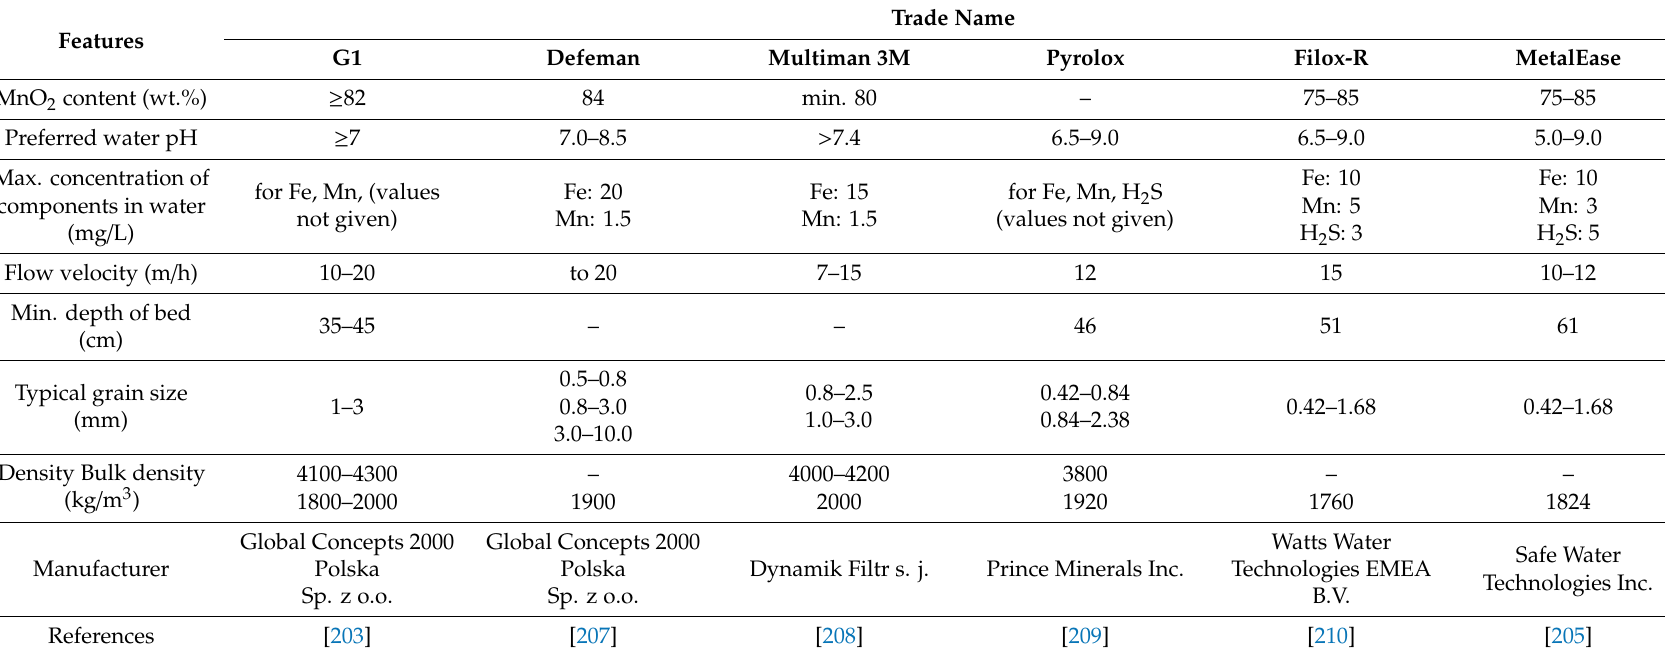
Table 7. Features of commercial catalytic filter media consist of manganese ore. Adapted from